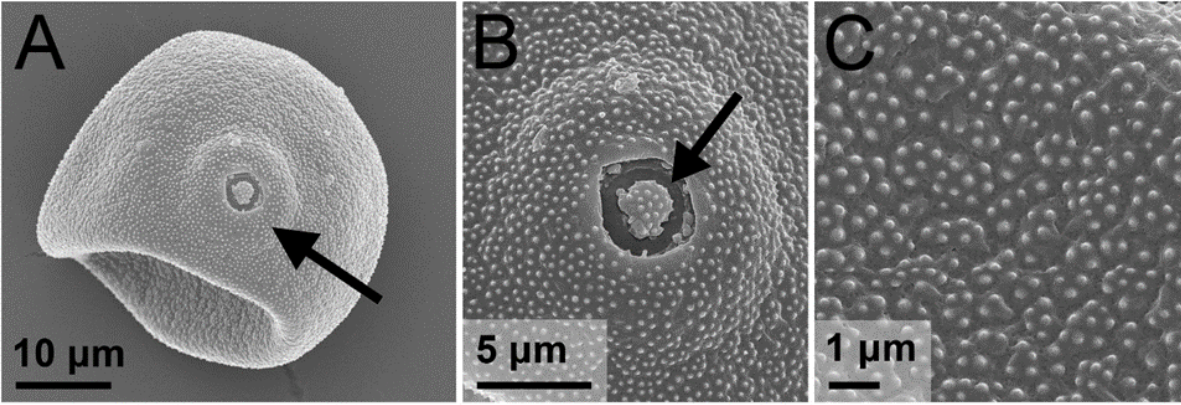
Figure 4. View of D. obovata pollen surface under SEM at A) 2000× B) 5000× C) 10000× magnifications. Arrows indicate the annulus in A and the operculum in